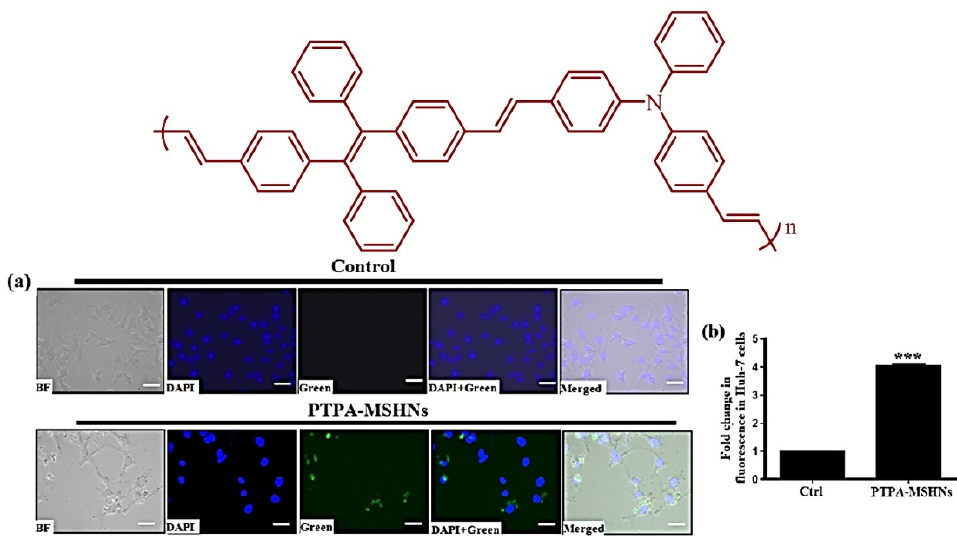
Figure 22. Demonstrates the structure of the fluorescent PTPA luminogenic probe. ( a ) Fluorescent microscopic images of cells when treated with PTPA-MSHNs (100 μ g/mL) for 24 h. In cells marked as “control”, shows no addition of PTPA-MSHN; BF stands for bright field; to stain the nucleus DAPI counter stain were used. Scale bar represents 20 μ m. ( b ) Quantification of fluorescence emitted by Huh-7 cells after treatment with PTPA-MSHNs (100 μ g/mL) for 24 h. “Ctrl” represents cells without treatment of PTPA-MSHN. The symbol (***) represents a significant difference as compared to untreated control. Reprinted from reference [105] with the permission of the American Chemical Society.